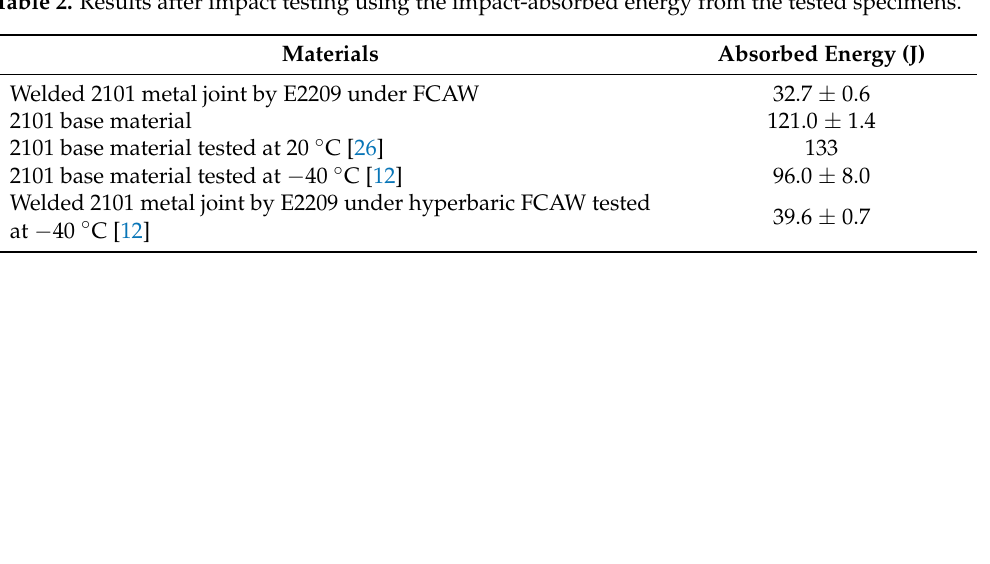
Table 2. Results after impact testing using the impact-absorbed energy from the tested